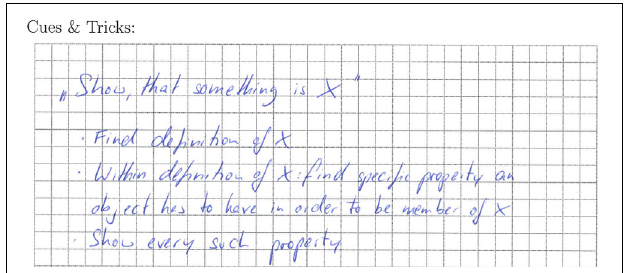
FIGURE 7 | Leia’s notes regarding mathematical strategic knowledge (translated).